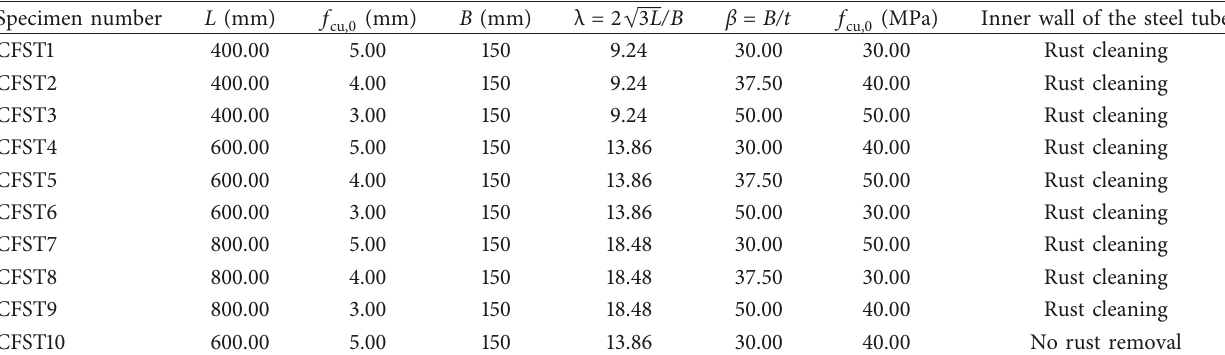
Table 1: Design parameters of the test specimens.